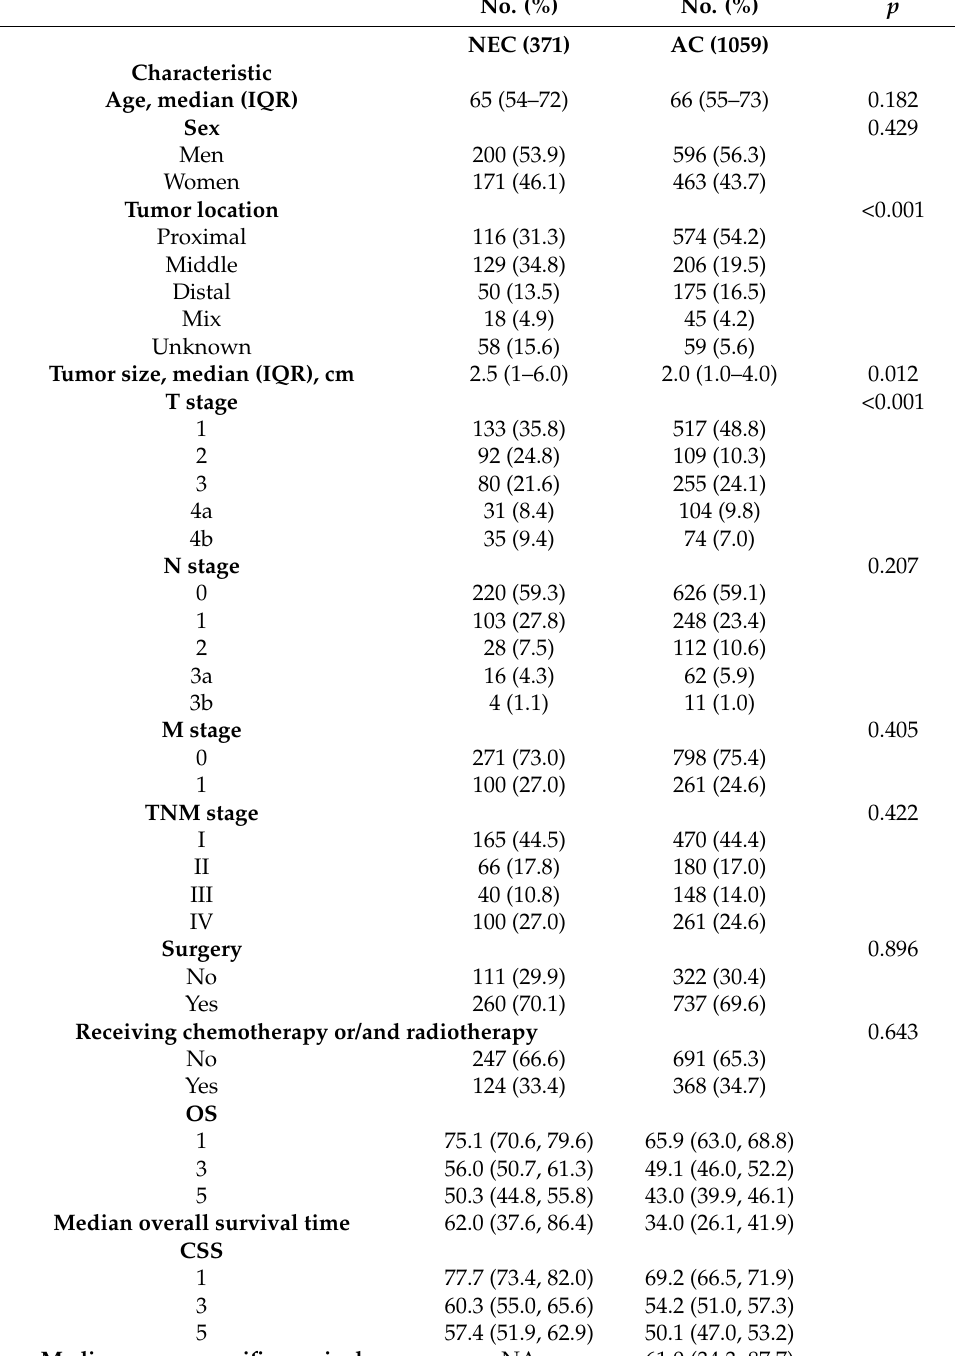
Table 2. Baseline Clinicopathologic Characteristics and Survival Outcomes of White Patients with Gastric Neuroendocrine Carcinoma and Adenocarcinoma in the Matched